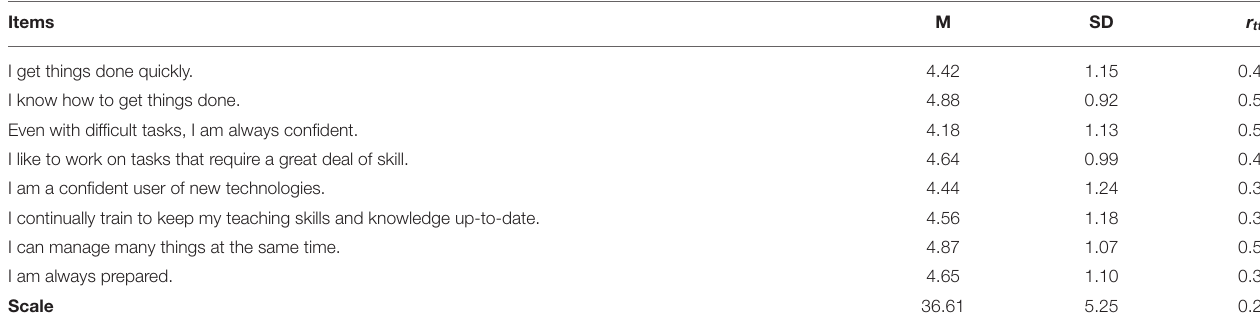
TABLE A5 | Sense of competence scale–means, standard deviations, and item-total score-corrected correlations of the items ( N = 1,944, α = 0.76, ω h = 0.76, λ 6 = 0.74, ρ = 0.67). Items M SD r tt I get things done quickly.